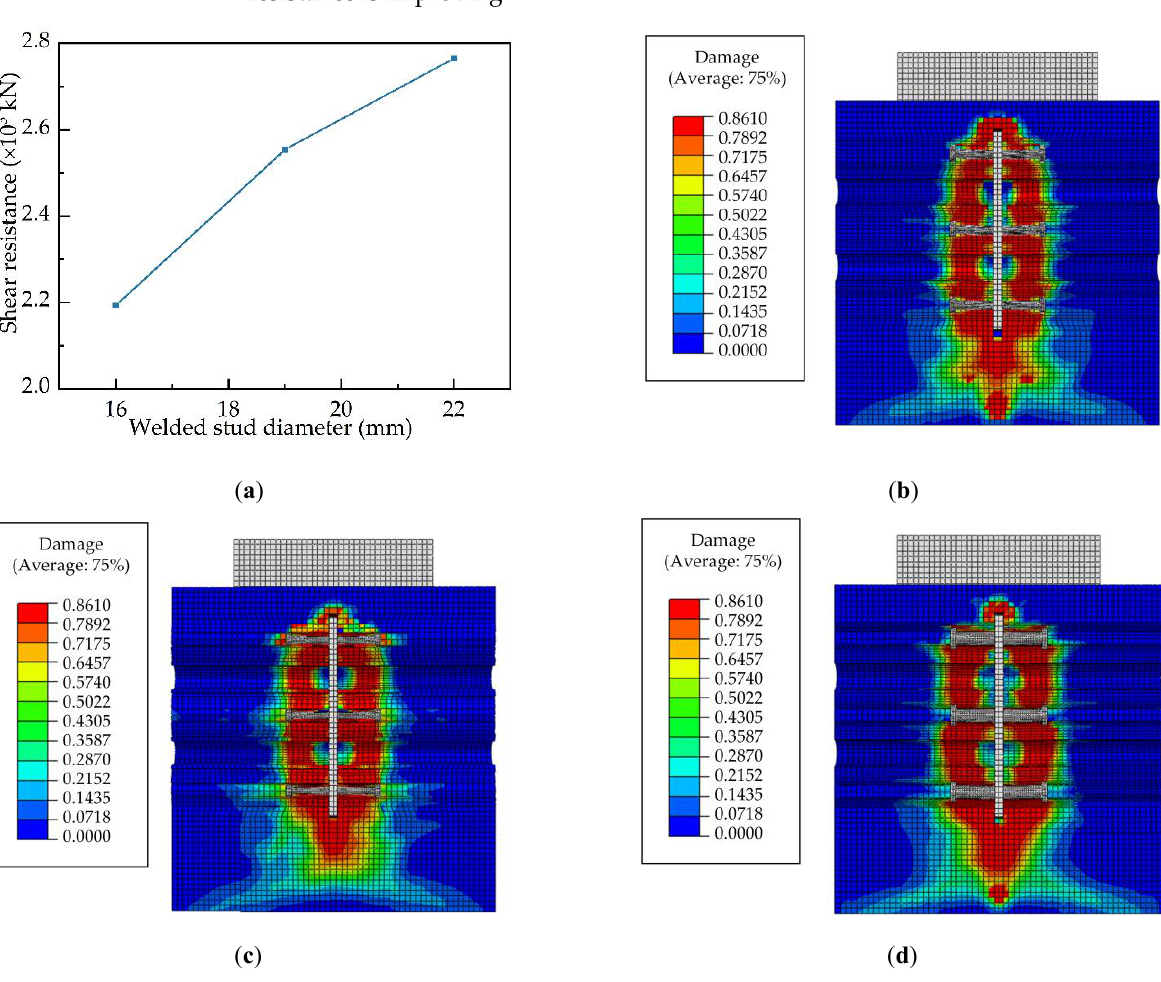
( d ) Figure 20. Influence of concrete strength: ( a ) shear resistance; ( b ) compressive damages cloud map of C30 concrete; ( c ) compressive damages cloud map of C50 concrete; ( d ) compressive damages cloud map of C60 concrete. 4.3.2. Welded Stud Diameter